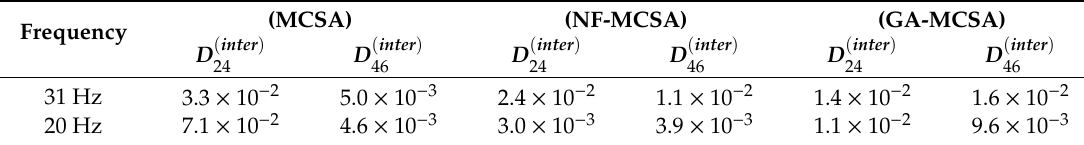
Table 2. Inter-cluster distance for the amplitudes of the LSH.